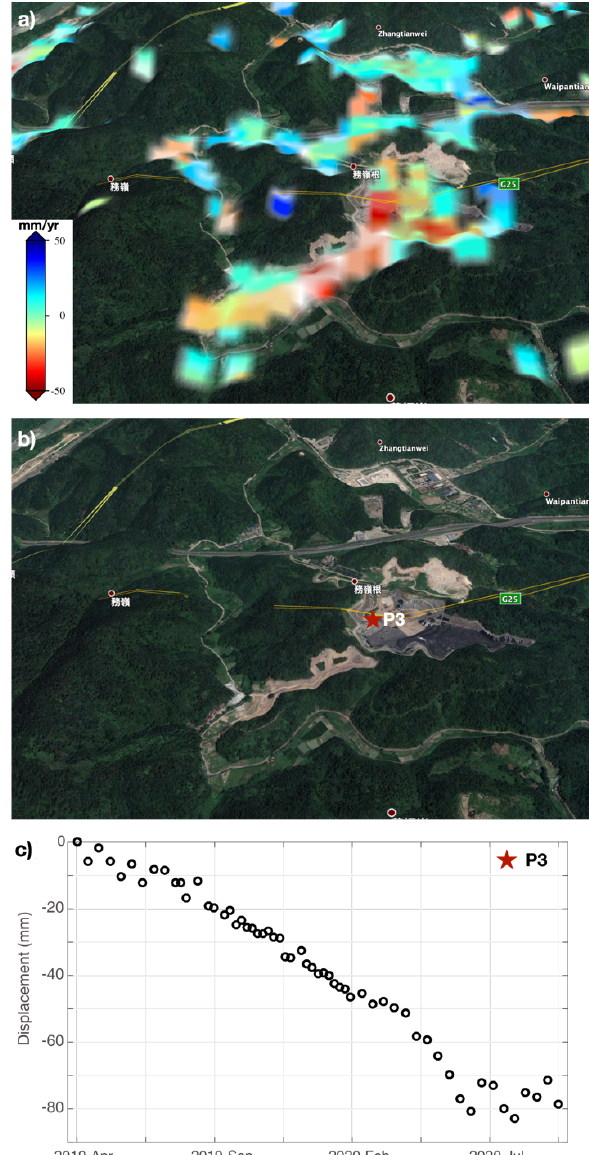
Figure 8 . (a) Subsidence velocities of a local refuse landfill site. (b) is the corresponding Google Earth TM image of (a). (c) Time- series displacement of P3 in the